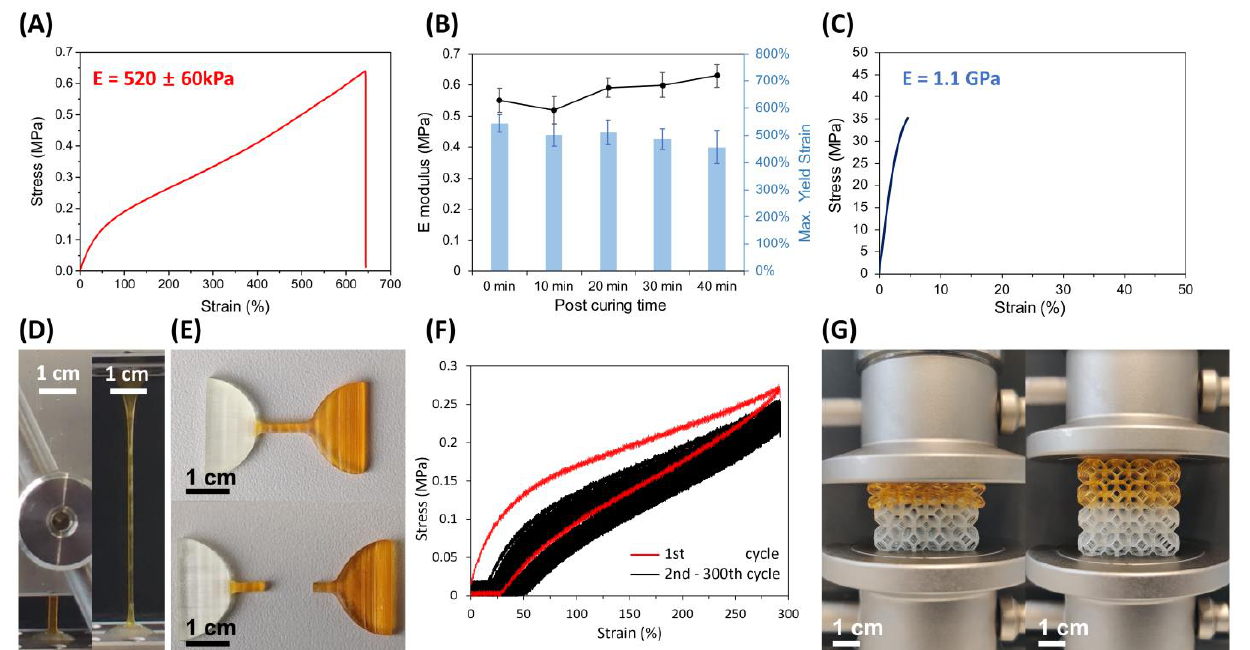
Figure 2. Mechanical characterization of the soft and multi-material components. ( A) The stress/strain curve of the printed soft material with a calculated Young’s modulus of 520 ± 60 kPa. ( B ) The maximum yield strain (bars) and Young’s modulus (line) of printed parts after different post-curing periods. ( C ) The stress/strain curve of the printed hard material with the calculated Young’s modulus of 1.1 GPa. ( D ) The multi-material component before and after 500% straining, with a stretched part size of 1.5 mm × 1.5 mm × 8 mm. The orange section (top) is the PEG-AA-based soft material, while the colorless section (bottom) is the hard material. ( E ) An overstretched multi-material component demonstrated that the component broke within the bulk and not at the interface. ( F ) The stress/strain curve of 300 rounds of cyclic loading of the multi-material component in ( D ) showed no cleavage or significant change in Young’s modulus during the repeated stretching. Here, the red line refers to the first cycle and the black line refers to the rest of the cycles. ( G ) Multi-material Kelvin’s foam (side length 4 cm). The left image shows the morphology of the lattice when compressed by 1.5 cm (75% of the soft part), while the right image shows the instantaneous rebound upon release (as in Supplementary Video S1).